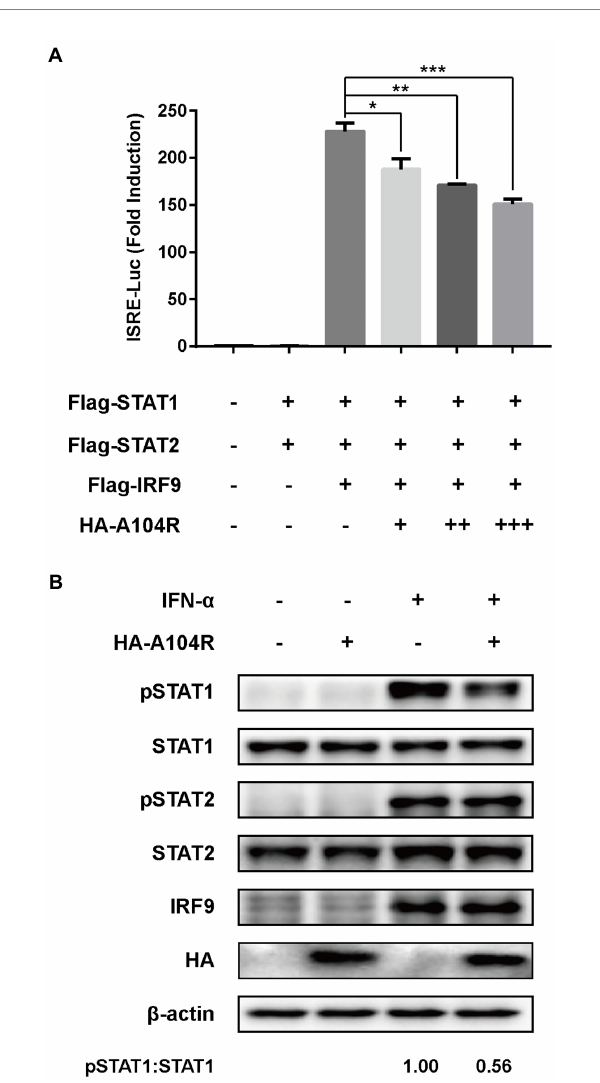
FIGURE 2 ASFV pA104R inhibits ISGF3-induced ISRE promoter activity and attenuates the phosphorylation of STAT1. (A) HEK-293 T cells were transfected with various concentrations of pA104R plasmids, along with ISGF3 complex (STAT1, STAT2 and IRF9) and pISRE-Luc and pRL- TK plasmids. After 30 h, a luciferase assay was performed. Data are shown as means ± SEM from three independent experiments. Statistical analysis was performed by one-way ANOVA. * p < 0.05; ** p < 0.01; *** p < 0.001. (B) HEK-293 T cells were transfected with pA104R or empty vector. After 24 h, cells were treated with 1,000 U/ ml IFN- α for 2 h. The levels of total or phosphorylated STAT1, STAT2, and IRF9 were detected by immunoblotting